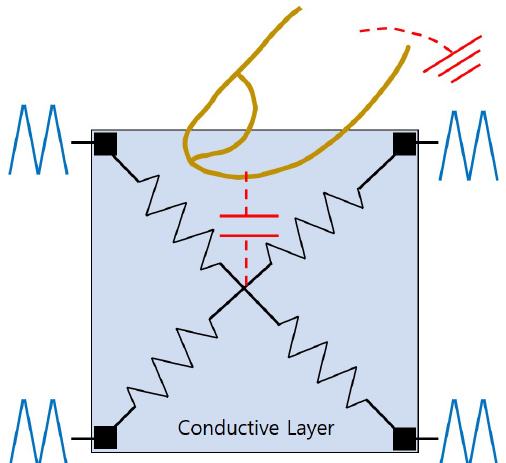
Figure 3. Surface-capacitive touchscreen. The touch location can be estimated from the current variation at four corner AC voltage sources caused by the finger